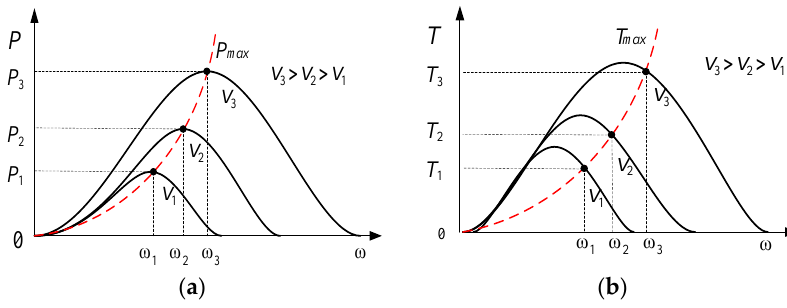
Figure 3. Wind turbine characteristic curves: ( a ) typical wind turbine power-speed characteristic curves for different wind speeds and the optimal power curve; and ( b ) typical wind turbine torque-speed characteristic curves for different wind speeds and the optimal torque curve.